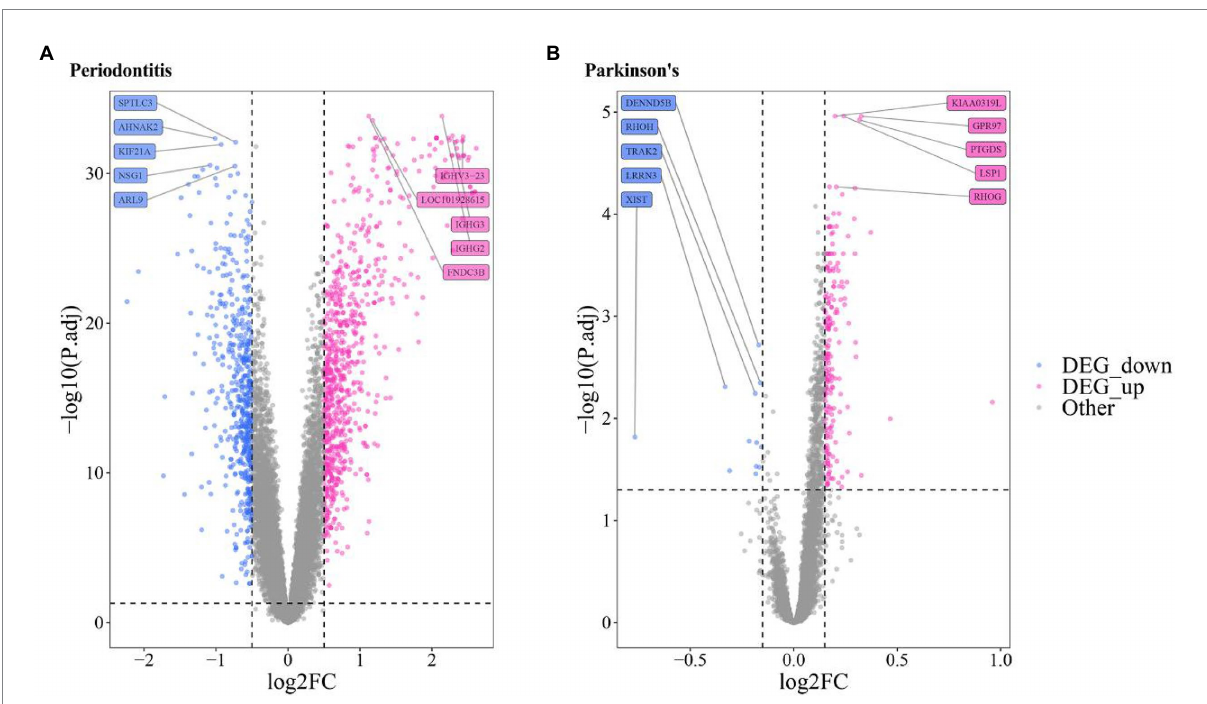
FIGURE 3 Volcanic map of the differentially expressed gene of (A) Periodontitis disease (A) and (B) Parkinson’s